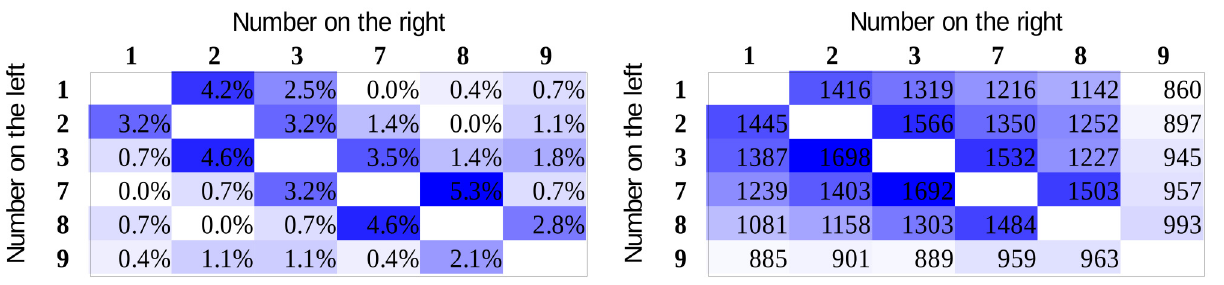
FIGURE 4 | Error rates (left) and reaction times (in ms, right ) in the whole stimulus space.